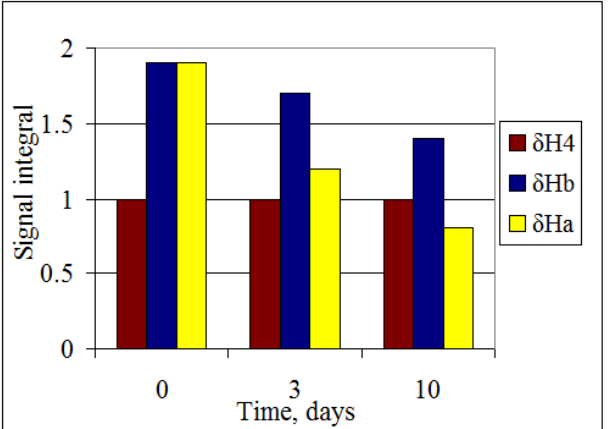
O solutions of compound 3b at 25 ° С 2